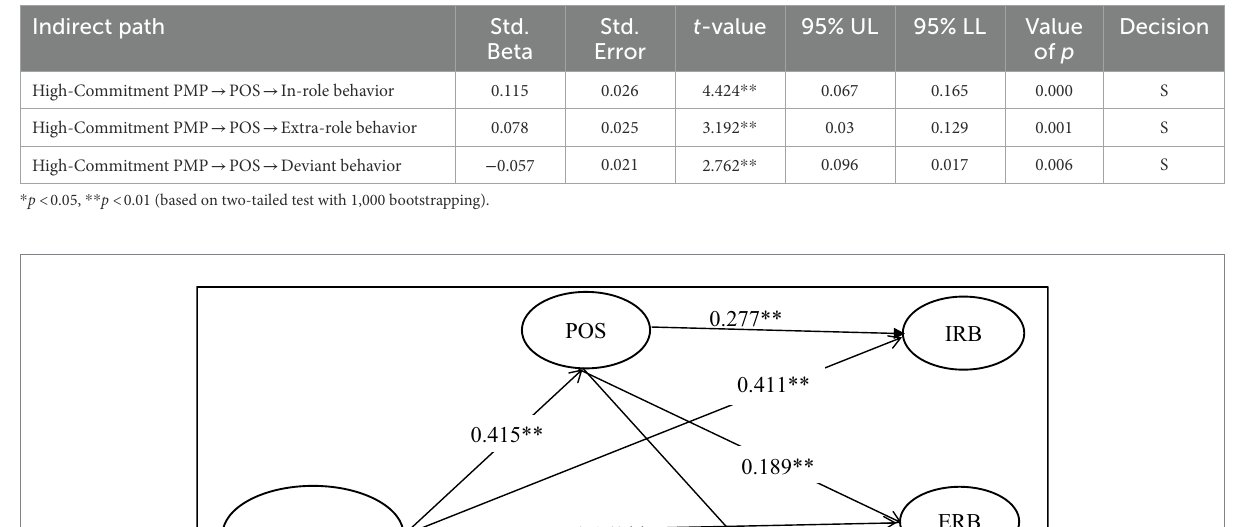
TABLE 6 Structural model indirect effect.